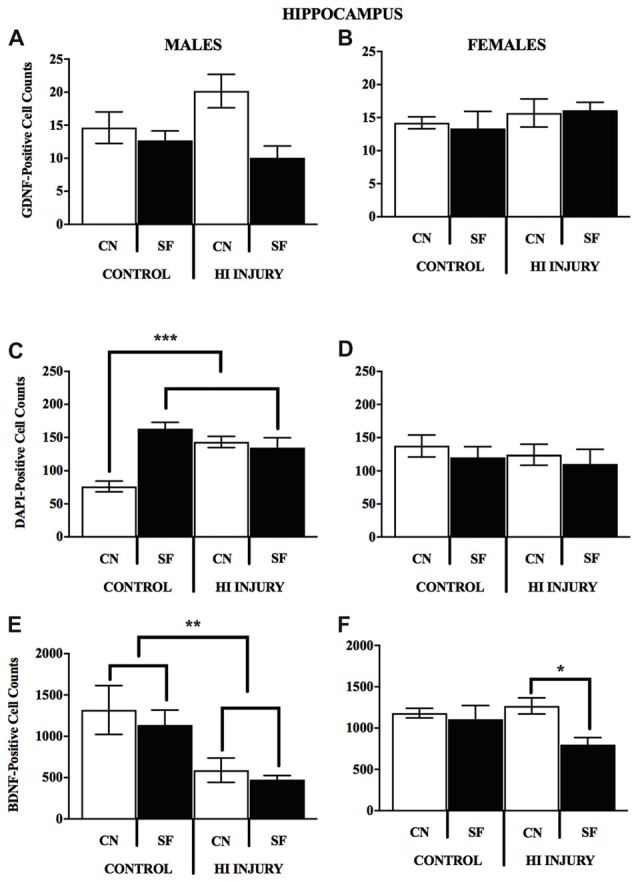
(A–F) Immunopositive cell counts for GDNF, DAPI and BDNF in hippocampus by surgery and housing conditions for both sexes. Bar graphs show average ±SEM counts for (A–B) GDNF-positive cells, (C–D) DAPI-positive cells and (E–F) BDNF-positive cells in the hippocampus. No significant main effects or interactions were observed for GDNF. For DAPI, male control rats reared in CN had fewer immunopositve cells relative to all other groups, ***p < 0.001. HI injury males reared in SF had fewer cells relative to Control males reared in the same condition, *p < 0.05, **p < 0.01.